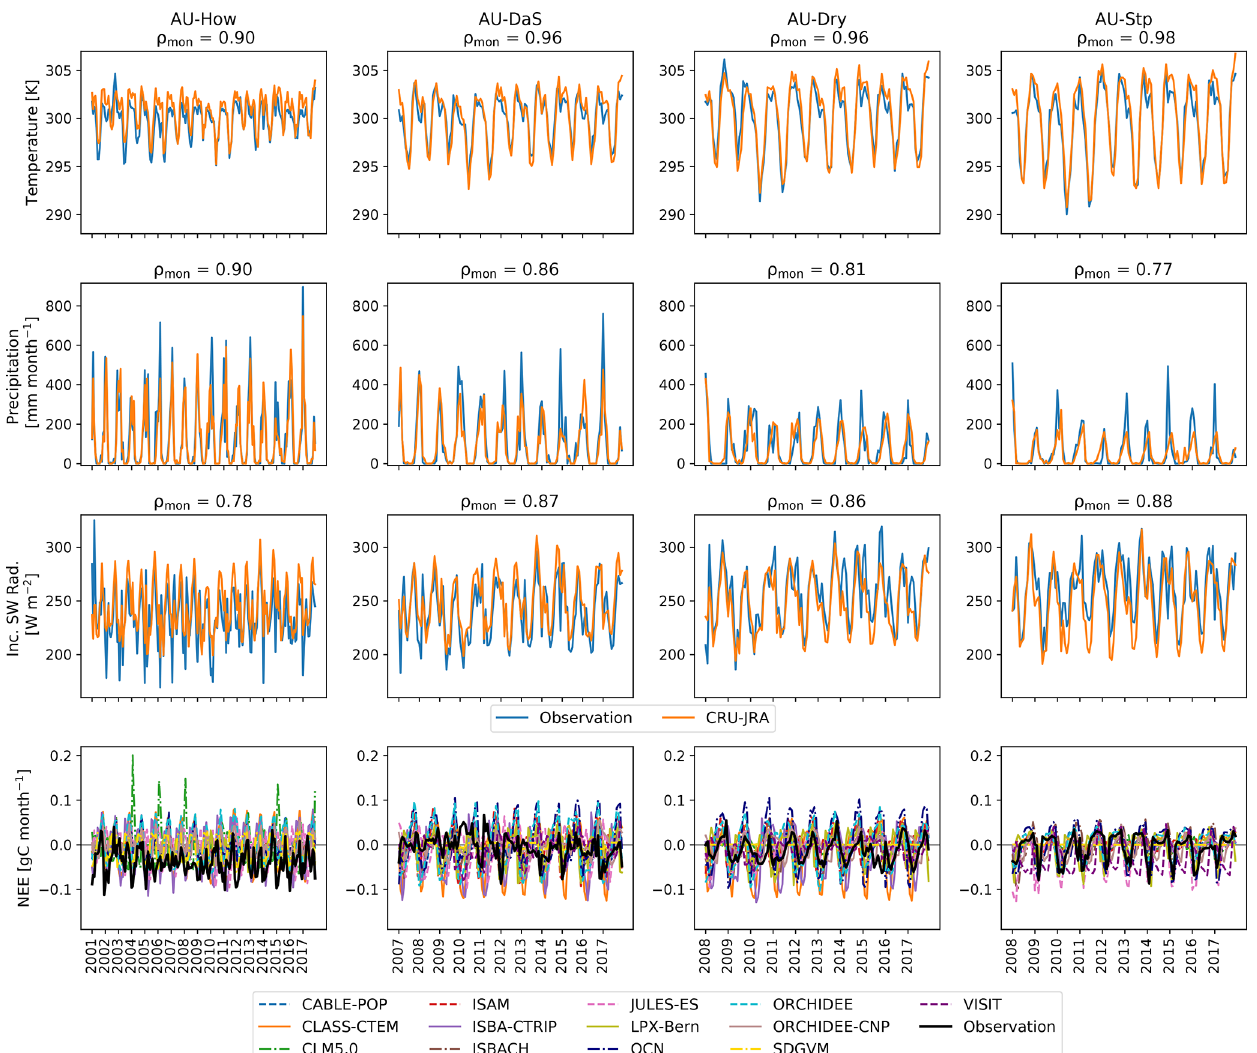
Figure C3. Monthly temperature, precipitation, and incoming short-wave radiation data that are observed (blue) and the corresponding data from the reanalysis product CRU-JRA (orange) for the four flux sites located in the Northern Australian Tropical Transect (NATT): Howard Springs (AU-How), Daly Uncleared (AU-DaS), Dry River (AU-Dry), and Sturt Plains (AU-Stp). The figure titles display the Pearson correlation coefficient between observation and reanalysis ( ρ mon ). The bottom panels show observed monthly NEE (black) and simulated NEE by the individual TRENDY